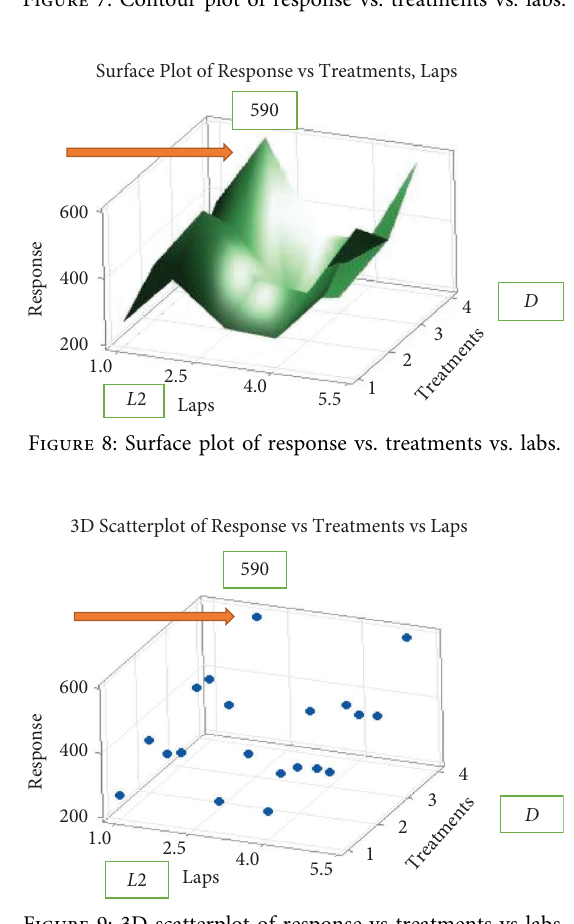
Figure 9: 3D scatterplot of response vs treatments vs labs.